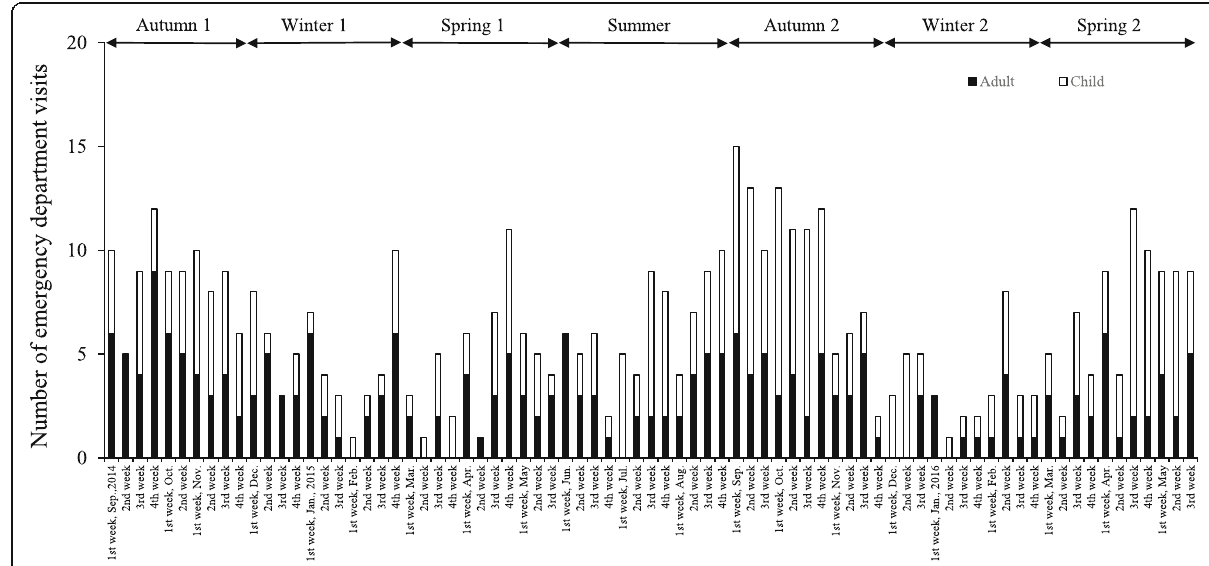
Fig. 1 Number of emergency department visits for asthma at Rakuwakai Otowa Hospital in Kyoto. The study period (September 2014 to May 2016) was divided into autumn (September to November), winter (December to February), spring (March to May), and summer (June to